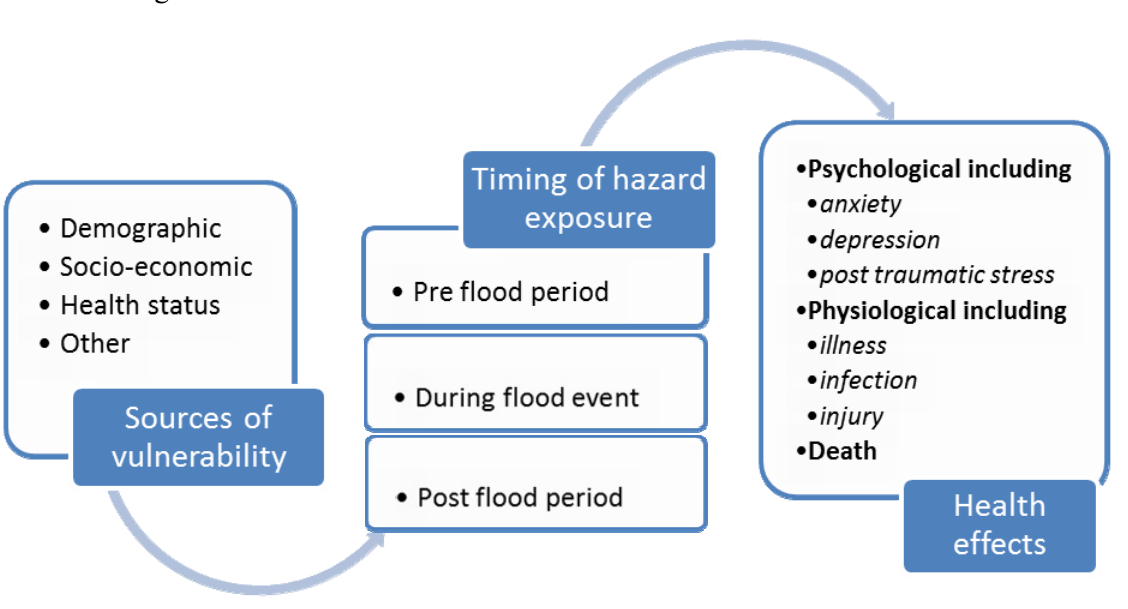
Figure 1. Factors increasing vulnerability to health effects of floods before, during and after